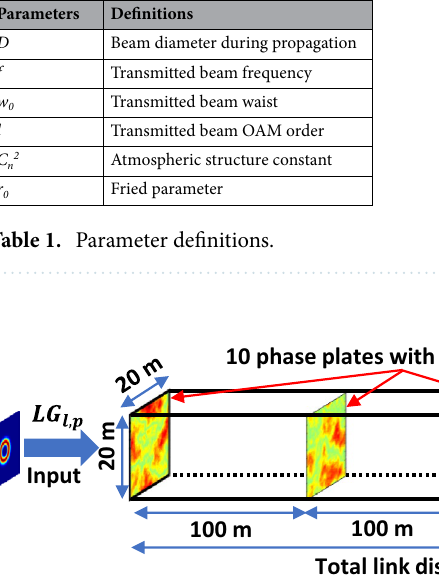
Figure 2. Schematics of the simulation model for studying atmospheric turbulence effects on THz OAM beams. 10 randomly generated phase plates with equal spacing of 100 m are used to emulate the turbulence for a total link distance of 1